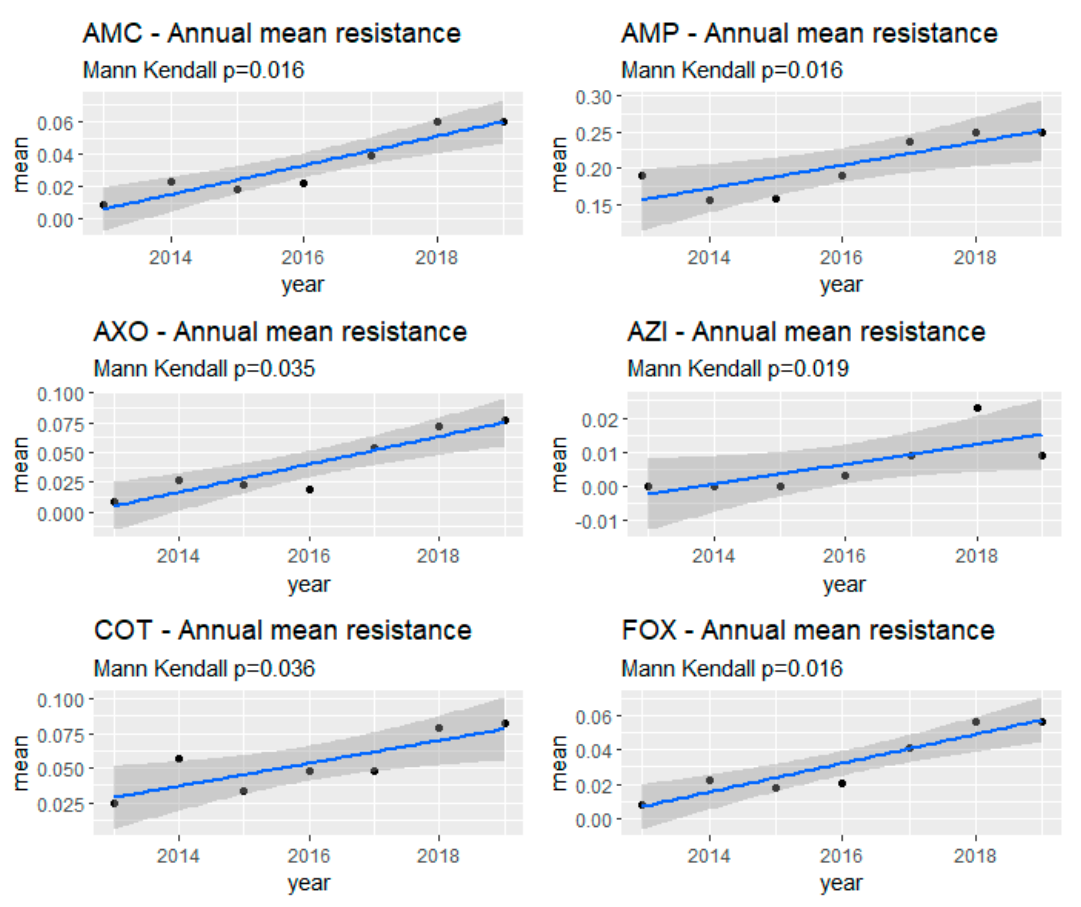
Figure 2. Antimicrobial resistance trends in commensal Escherichia coli (n = 3237) isolated from swine at slaughter across the US, 2013–2019. AMC ‒ Amoxicillin-Clavulanic acid; AMP ‒ Ampicillin; AXO ‒ Ceftriaxone; AZI ‒ Azithromycin; COT ‒ Trimethoprim-Sulfamethoxazole; FOX ‒ Cefoxitin.